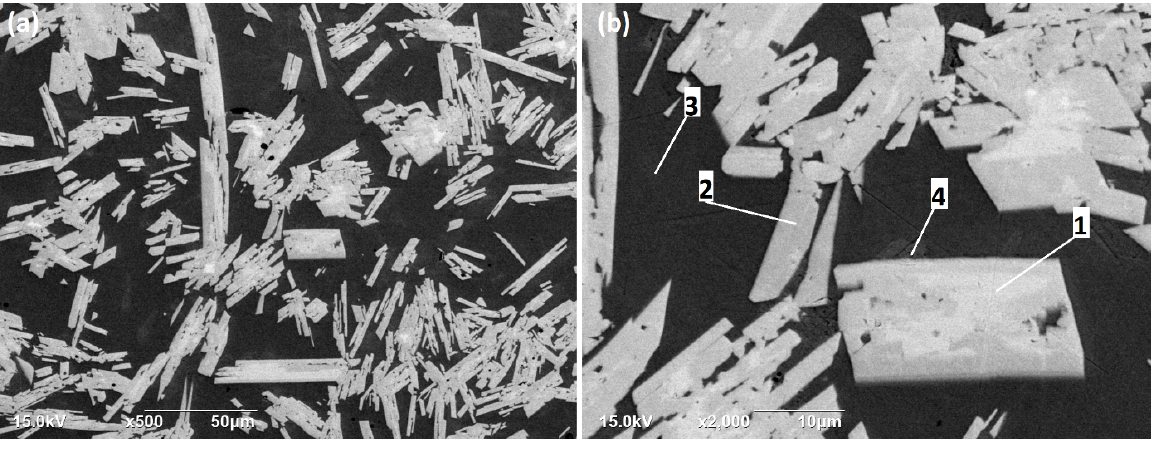
Figure 7: SEM/BSE images of the as-cast alloy sample F with the magnifications of a) × 500 and, b) ×